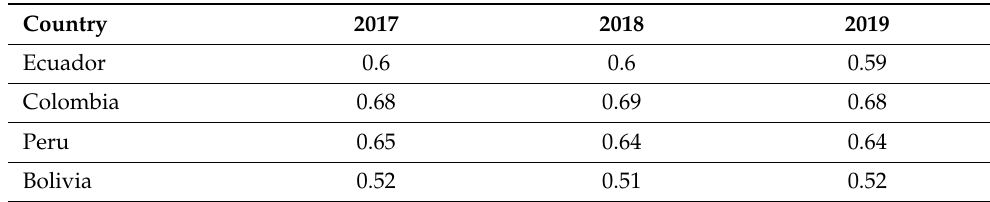
Table 11. The total scores in the environmental sustainability dimension in the Andean Community members.